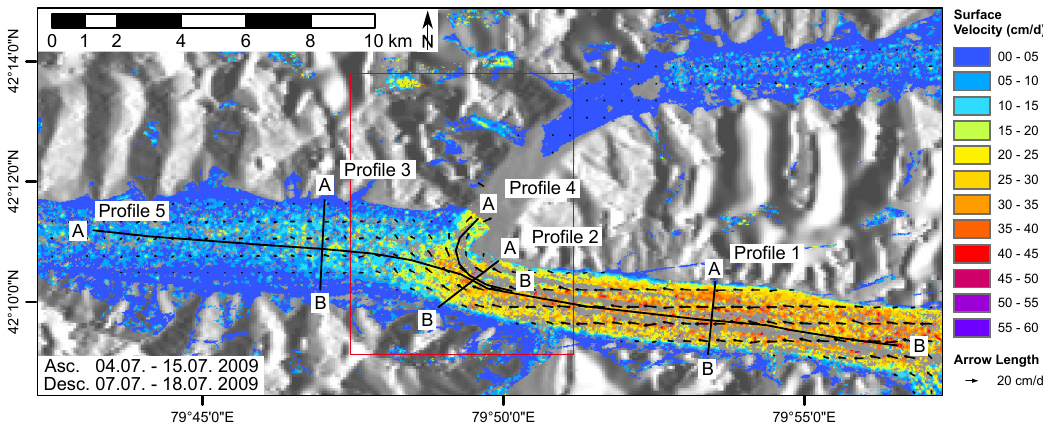
Figure 4. The average surface velocity resulting from the combination of the images from 4–15 June 2009 (ascending) and 7–18 June 2009 (descending). The kinematic information is projected on a hillshade image derived from SRTM–DEM data. The amount of the displacement is colour-coded as well as shown by the length of the arrows. The points of the arrows indicate the flow direction of the glacier surface. The red rectangle marks the outline of the time series samples collected from 2009 and 2010 (Figure 5). The location of the profiles, running from A to B (Figure 6), are shown as black